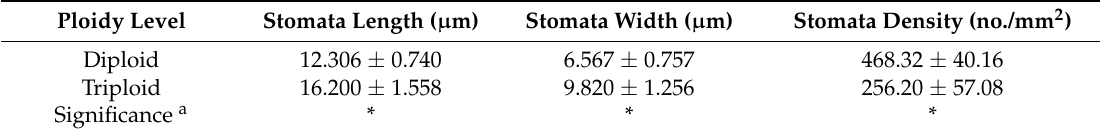
Table 5. Stomatal characteristics of diploid and triploid plants in Eucalyptus urophylla.